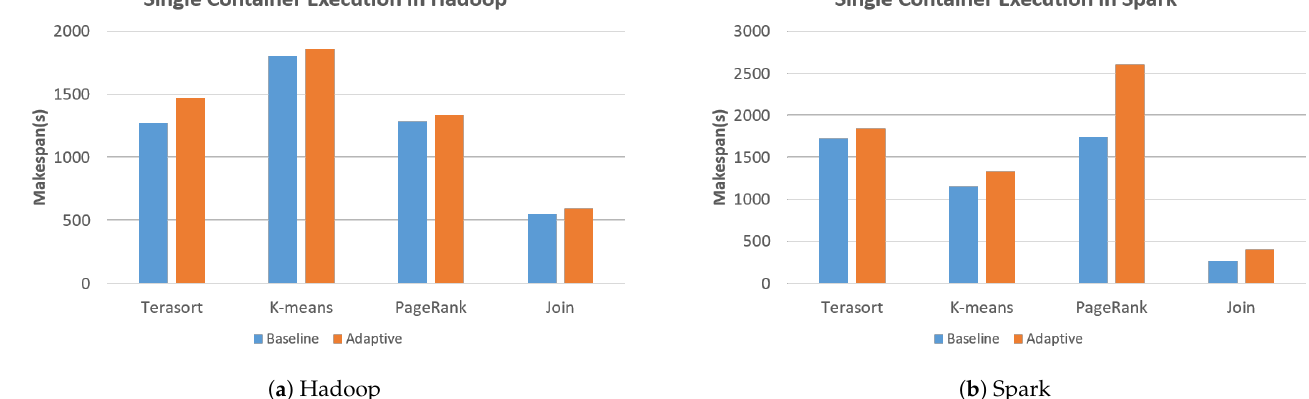
Figure 2. Experimental results of single-container executions that can show the overheads of our proposed approach compared to the best performance in the given computing environment.